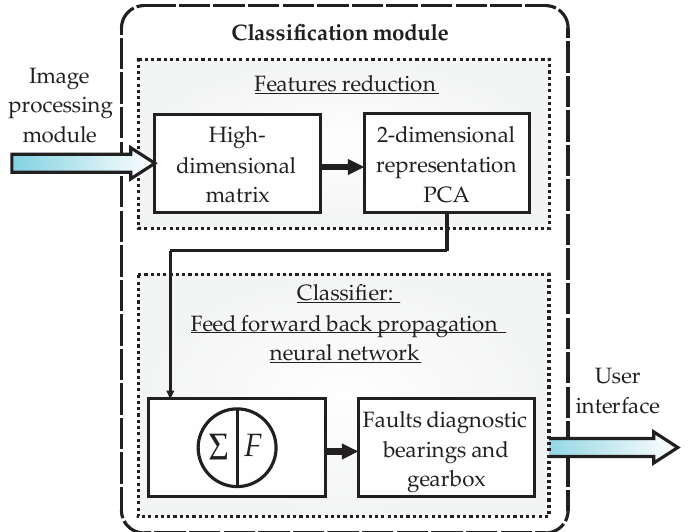
Figure 8. Block diagram of the classification module in the smart sensor.